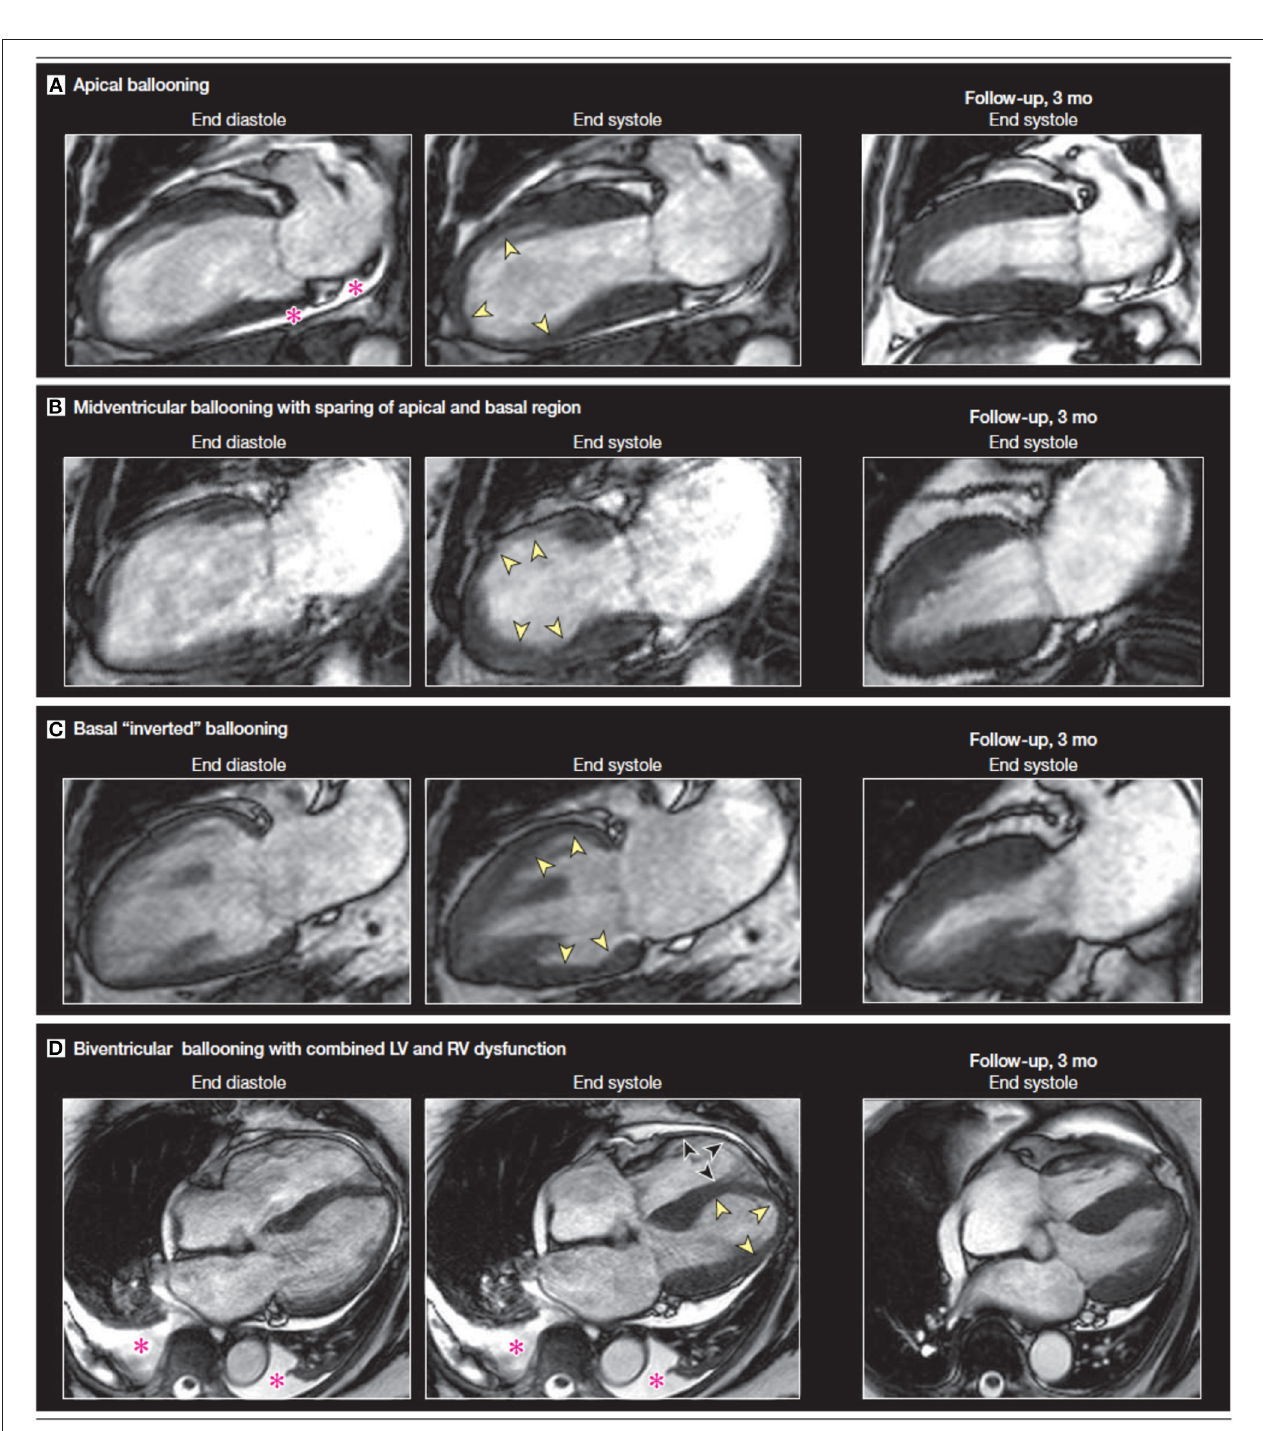
FIGURE 2 | A comparison of vertical long axis CMR cine sequence images on diagnosis and at 3-month follow-up showing a recovery of wall motion abnormalities. The four sets of images display four different variants associated with stress CM. The pink asterisk denotes a pericardial effusion. Yellow arrows indicate apical akinesis while the black arrows indicate RV apical akinesis in the biventricular ballooning variant. Figure adapted from Figure 2 on Clinical Characteristics and cardiovascular magnetic resonance findings in stress (Takotsubo) cardiomyopathy by Eitel et al.